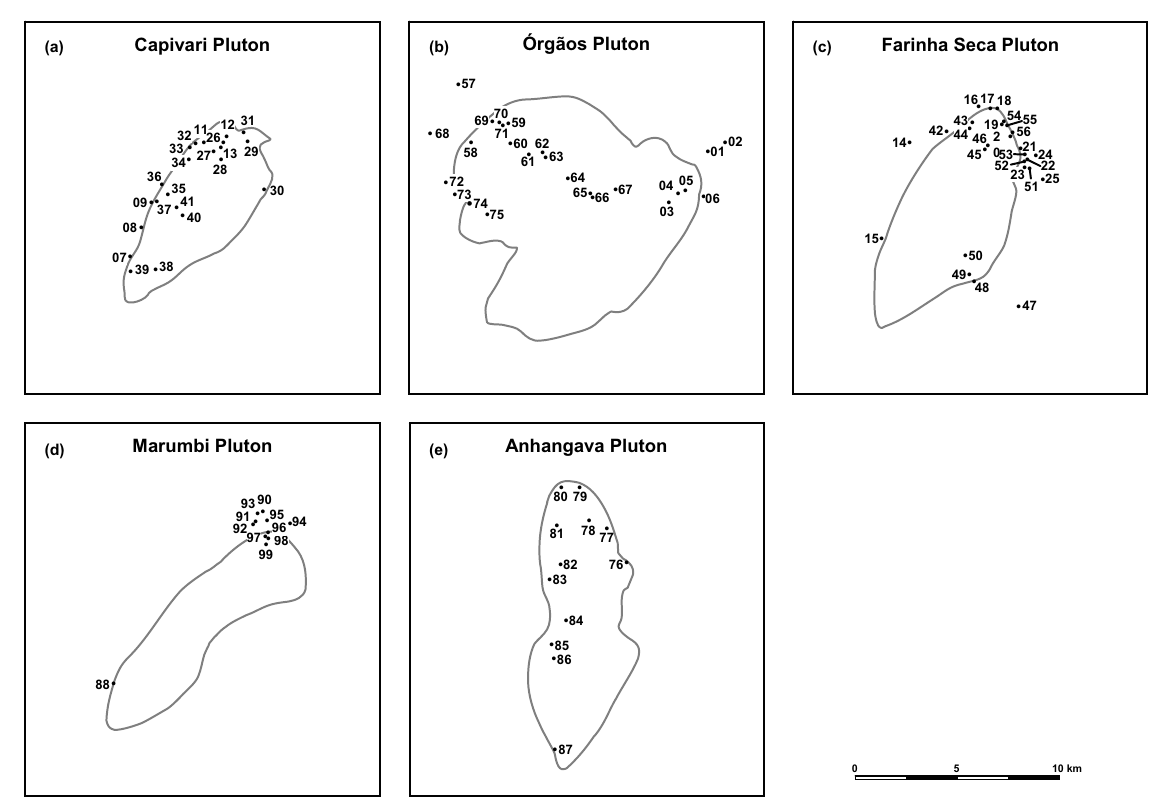
Fig. 6 – Outline of the five individual plutons showing the location of sample collection sites. All plutons are shown at the same scale. Notice that a significant number of points fall outside the traced contact between granites and country rocks; in all cases, these points are on the foothill of steep escarpments of the Serra do Mar, and indicate movement of decametric blocks for large distances (see text for